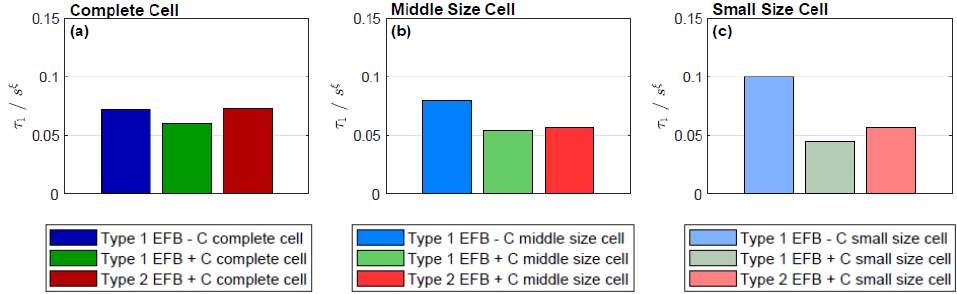
Figure 8. Fitting result τ 1 of the laboratory test cells for ( a ) complete cell: 8P8N/8P9N, ( b ) middle size cell: 3P2N and ( c ) small size cell: 2P1N.